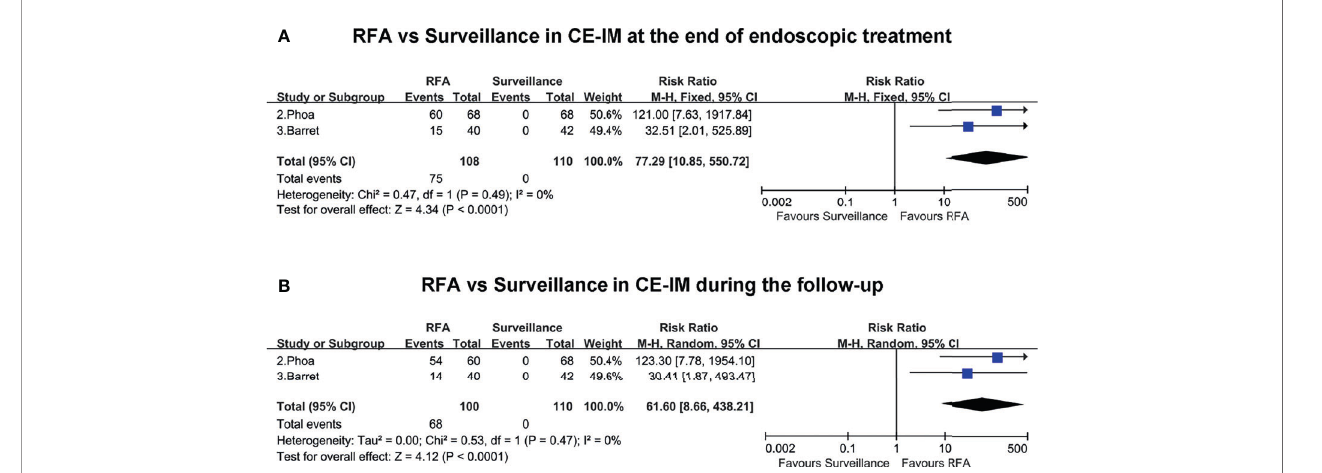
FIGURE 4 | (A) RFA vs. surveillance for CE-IM at the end of endoscopic treatment. (B) RFA vs. surveillance for CE-IM during the